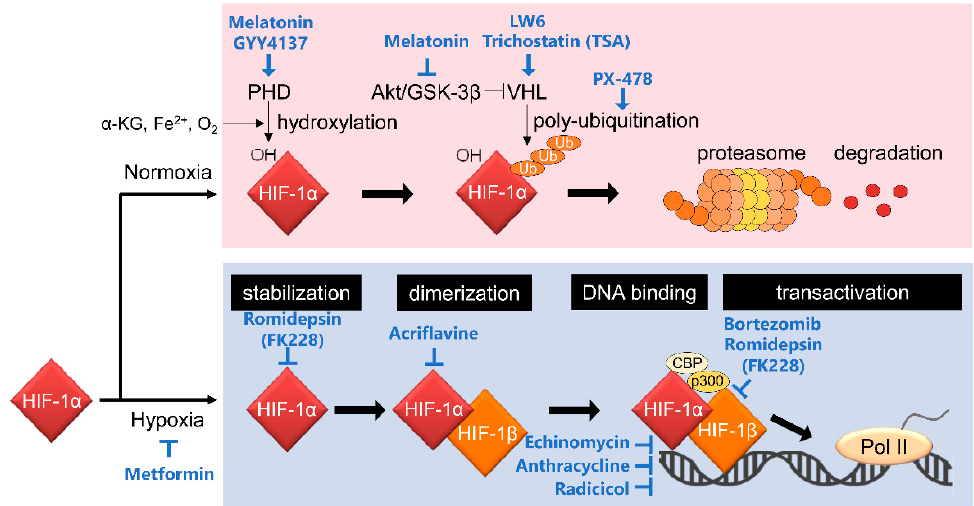
Figure 1. Canonical regulatory mechanisms behind the activation of HIF-1 and HIF-1 inhibitors targeting them. HIF-1 activity is mainly regulated at the HIF-1 α protein stability level through PHD-dependent hydroxylation and VHL-mediated ubiquitination. See the main text for details.